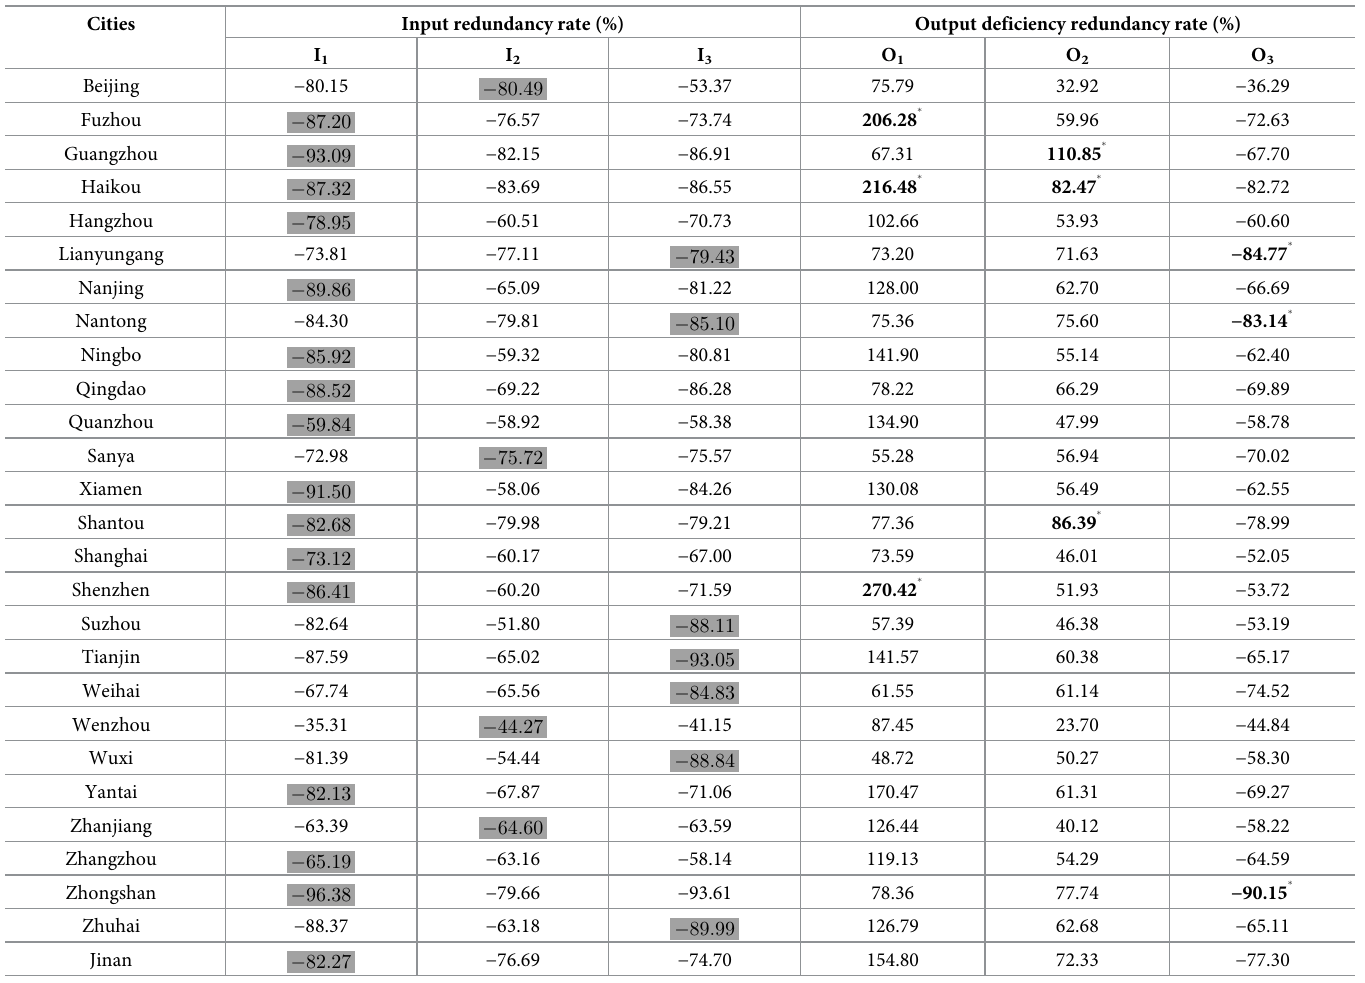
Table 4. Input–output optimisation result of tourism development in the main eastern cities.